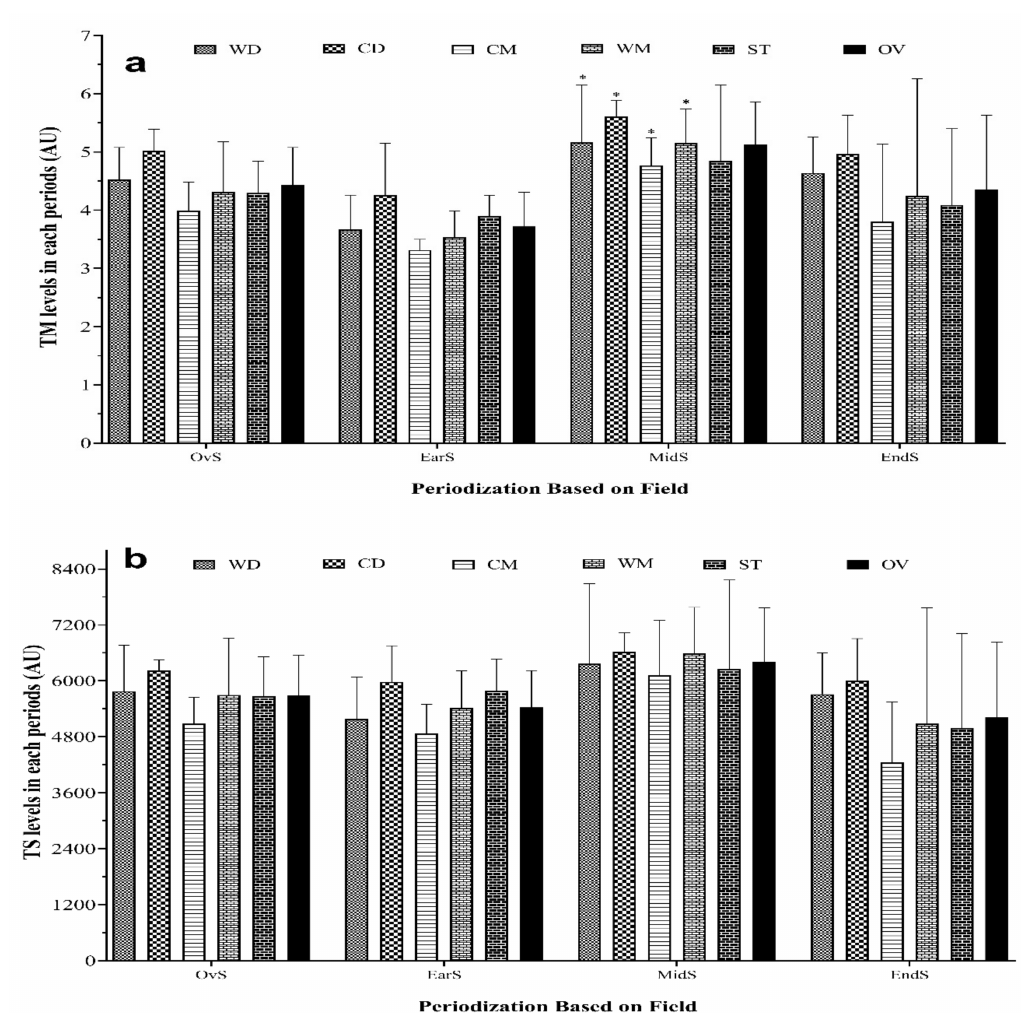
Figure 3. wTM ( a ) and wTS ( b ) patterns over periods and playing (field) positions and the whole team. WD, wide defenders; WM, wide midfielders; CD, central defenders; CM, central midfielders; ST, strikers; OV, whole team; TM, weekly training monotony; TS, weekly training strain. * Represents a statistically significant difference compared with Ear-S ( p ≤ 0.05); Represents a statistically significant difference compared with Mid-S ( p ≤